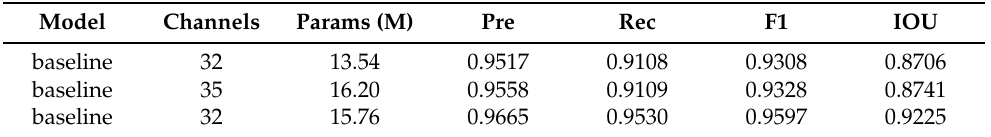
Table 4. Comparison of the baseline network (Figure 6), the wide baseline network, and our proposed method (using only